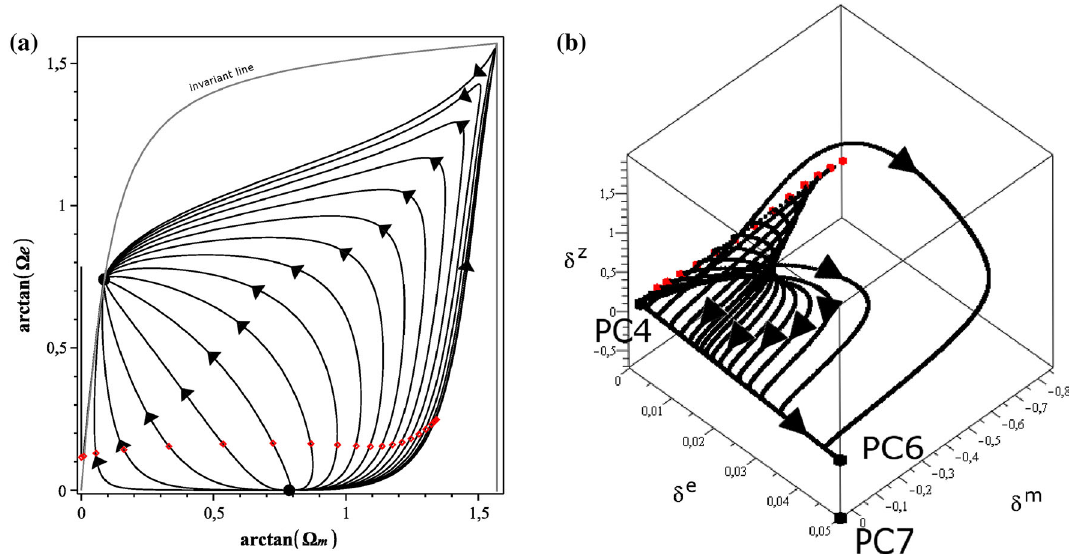
Fig. 5 a Homogeneous projection of the trajectories of the system (20a–20e) for the different shells of the configuration with initial con- ditions given by (31) and w = − 1 . 0, α = 0 . 1. The grey line represents the invariant line for this choice of parameters. The points represent the